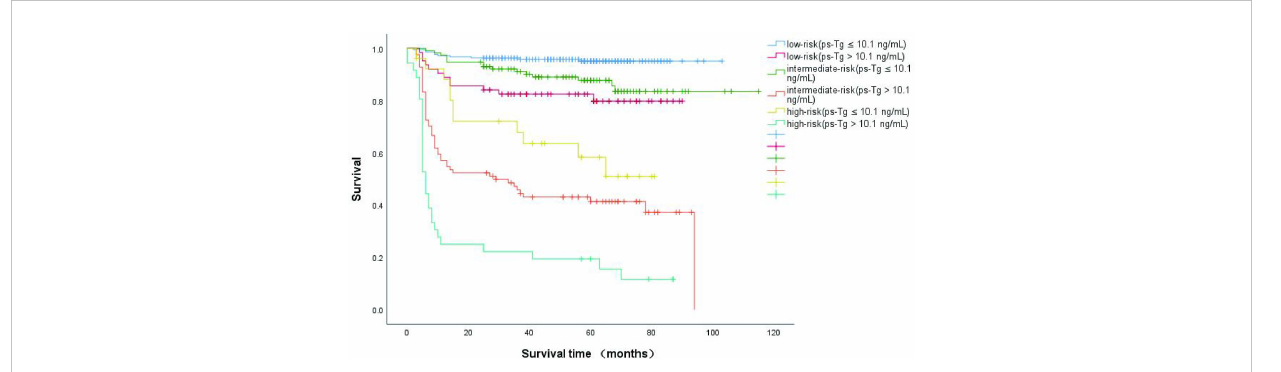
FIGURE 4 Kaplan-Meier curves for disease-free survival (DFS) in DTC patients according to size of the largest metastatic LN and the integration with ps-Tg, which were measured after thyroid hormone